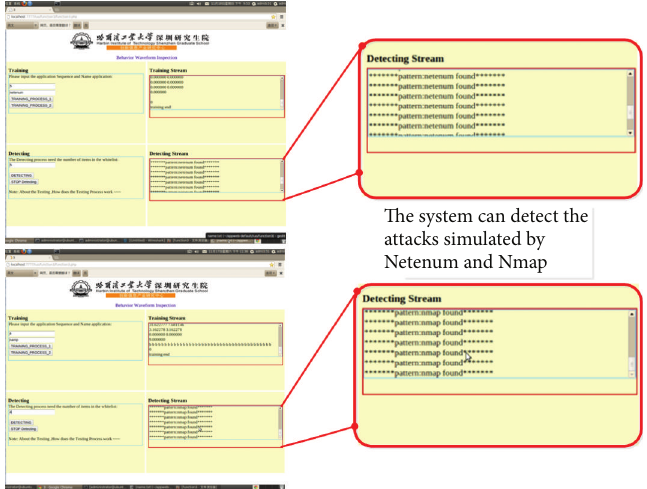
Figure 14: Detection of simulated